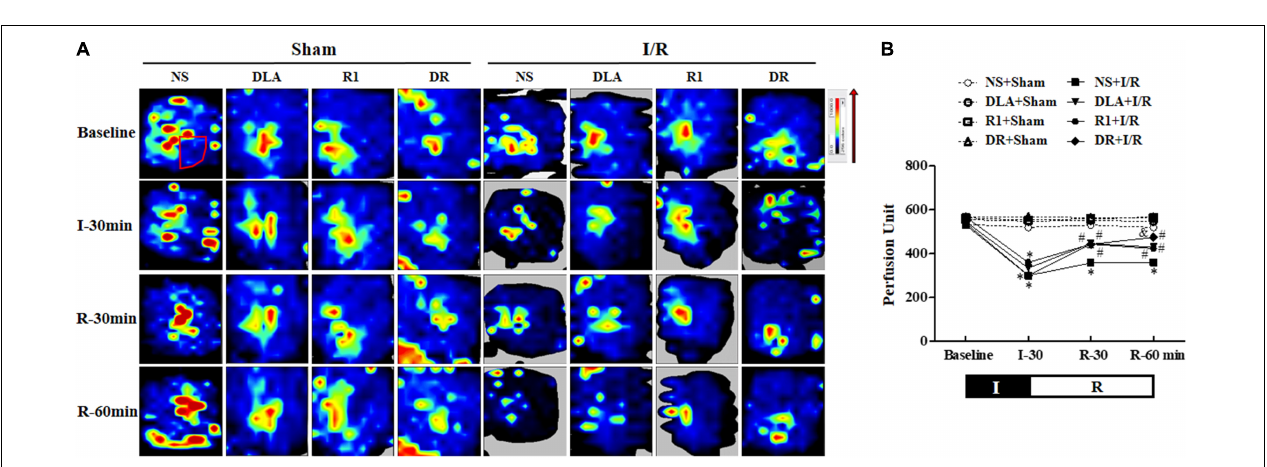
FIGURE 1 | The effect of 3,4-dihydroxyl-phenyl lactic acid (DLA), notoginsenoside R1 (R1), and a combination of 3,4-dihydroxyl-phenyl lactic acid and notoginsenoside R1 (DR) pretreatment on the myocardial infarct of rats subjected to ischemia reperfusion (I/R) for 90 min. (A) Example slice of 2,3,5-triphenyltetrazolium chloride (TTC)-stained left ventricle in the NS + Sham, DLA + Sham, R1 + Sham, DR + Sham, NS + I/R, DLA + I/R, R1 + I/R, and DR + I/R groups. The myocardium infarct is revealed as pale white. (B,C) The quantitative analysis of area at risk/left ventricular (AAR/LV) and infarct area/AAR 90 min after I/R in the different groups. Data are mean ± SEM (n = 6). * p < 0.05 vs. NS + Sham group; # p < 0.05 vs. NS + I/R group; & p < 0.05 vs. DLA + I/R and R1 + I/R group.